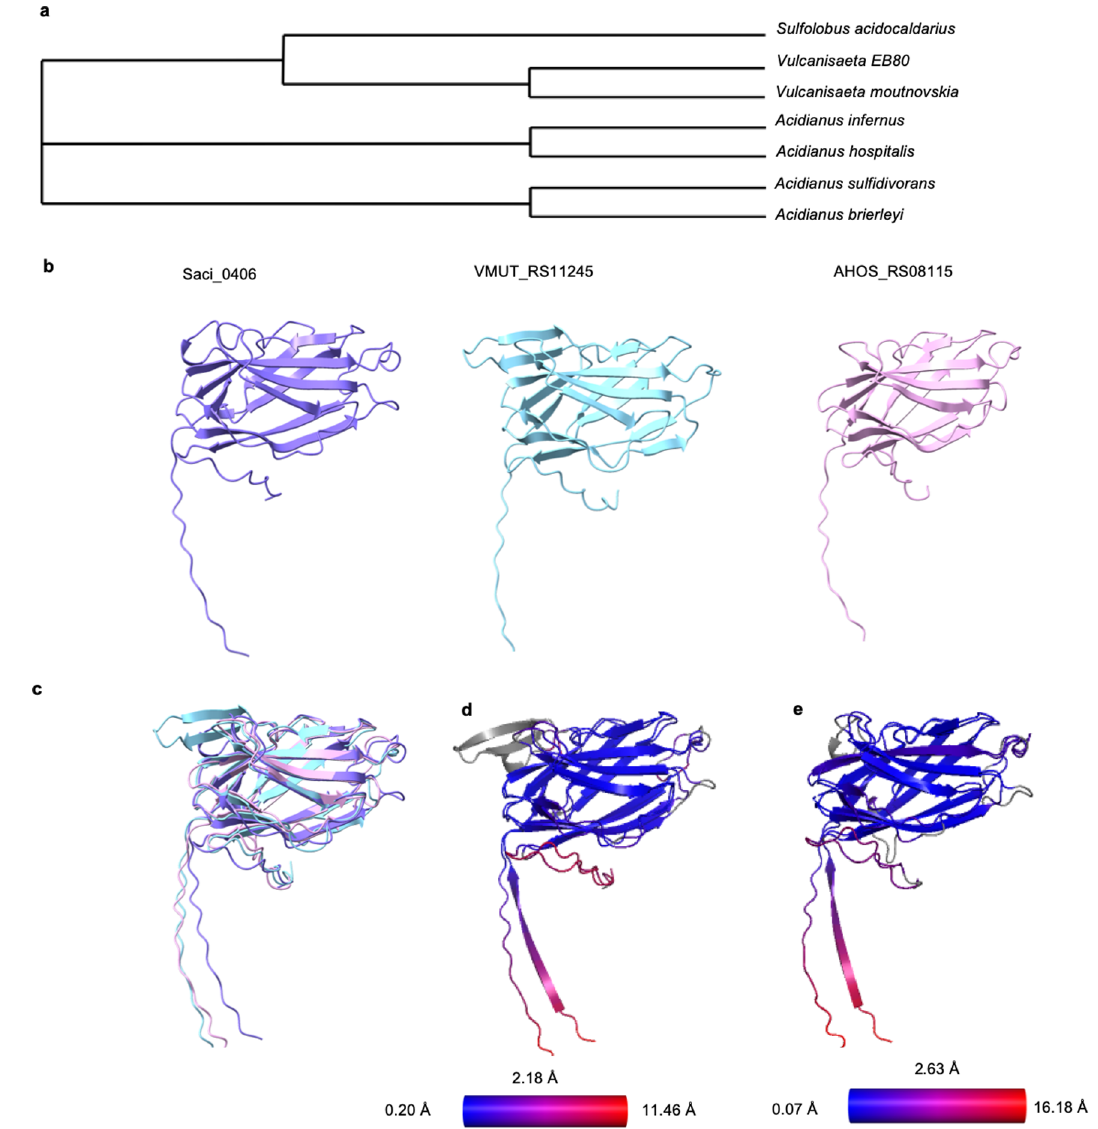
Fig. 3 | Threads are conserved in crenarchaeal relatives. a Phylogenetic tree of species where Saci_0406 homologues have been identi fi ed. b Saci_0406 (purple) compared with Alphafold2 predictions of homologues found in V. moutnovs- kia (blue) A. hospitalis (pink). c Superimposing the structures from B shows their